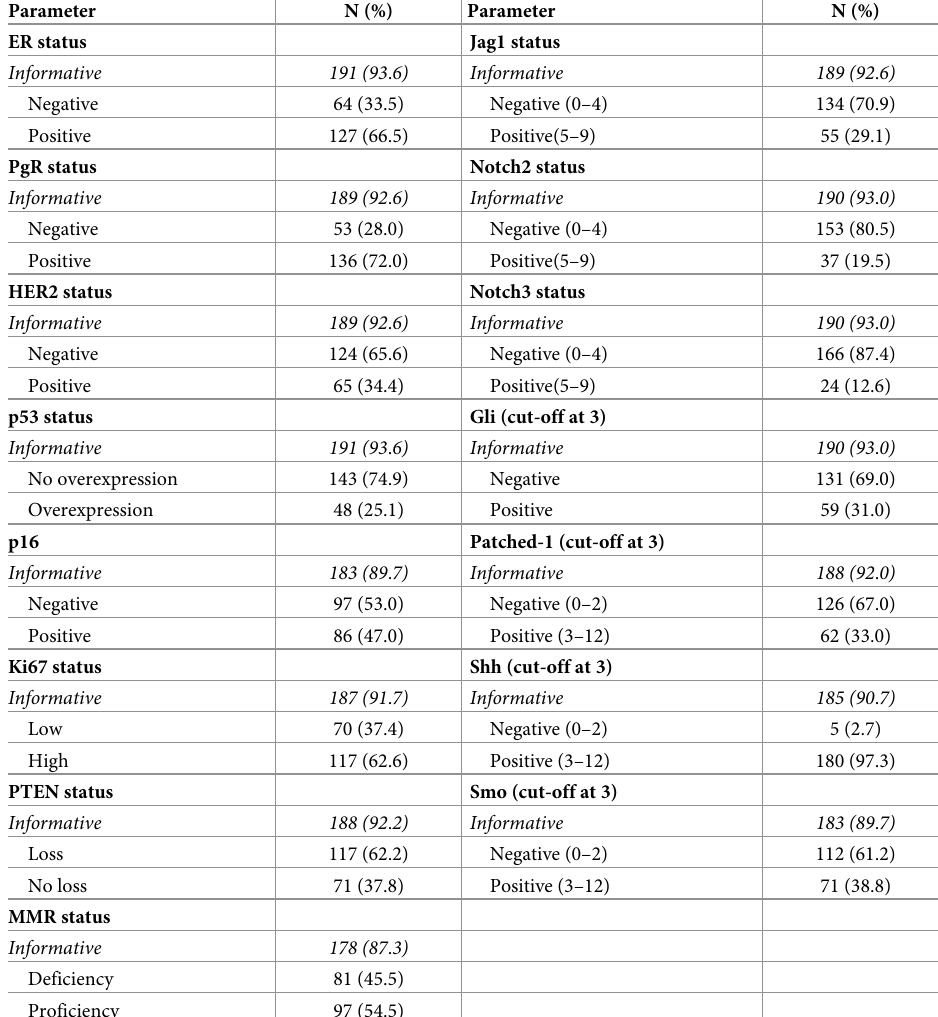
Table 2. Immunohistochemical results for all